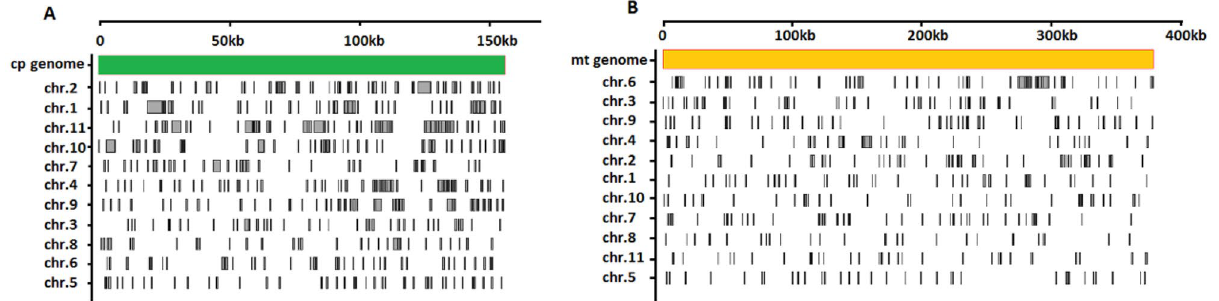
Figure 2. Distribution of homologous genomic sequences between the chloroplast, mitochondria, and nucleus in C. lanatus. ( A ) Indicates comparisons between chloroplast genome and nuclear genome; ( B ) indicates comparisons between the mitochondrial and nuclear genomes.